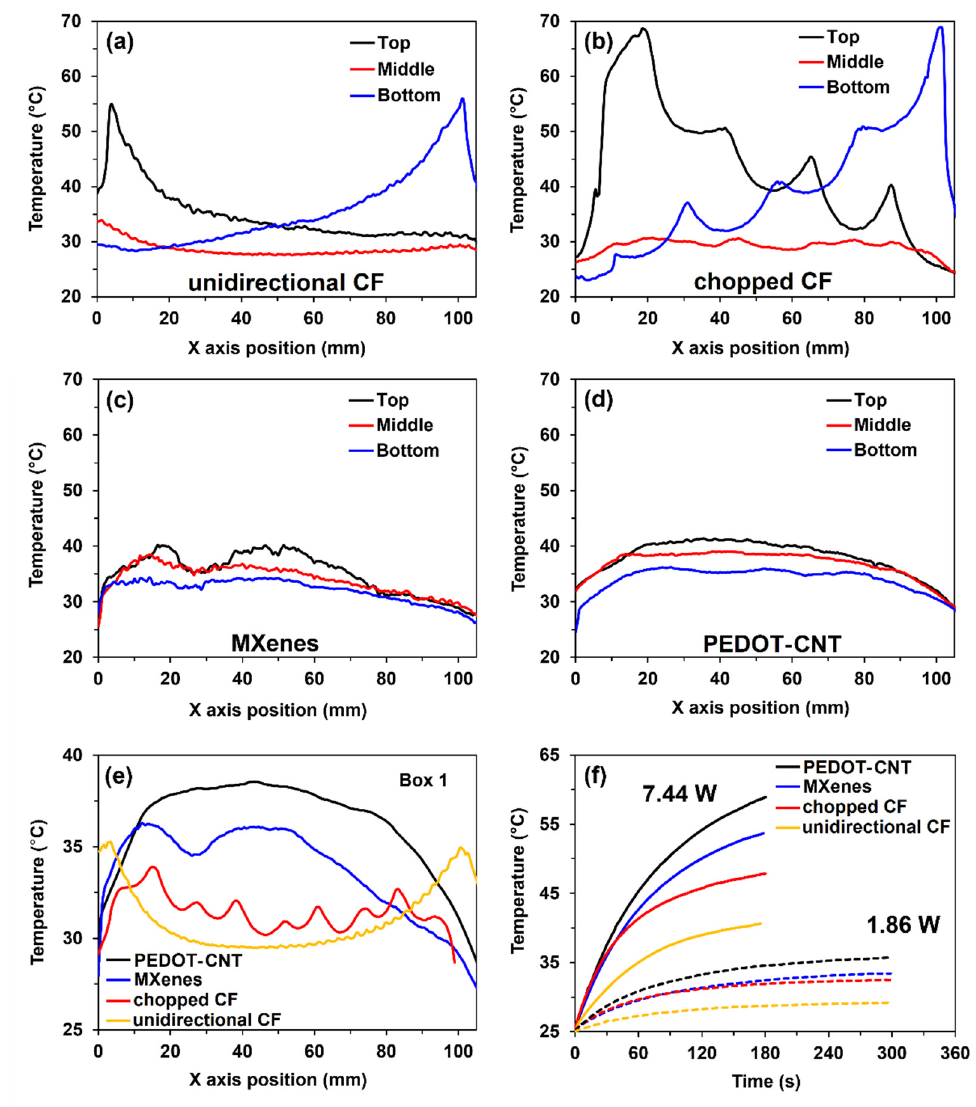
Figure 7. Comparison of temperatures along three linear sections under 1.86 W and 300 s of: ( a ) unidirectional CF; ( b ) chopped CF; ( c ) MXenes; ( d ) PEDOT-CNT; ( e ) average temperature results of the coatings across the sample length under 1.86 W and 300 s; ( f ) average temperature increase overtime under 1.86 and 7.44 W.